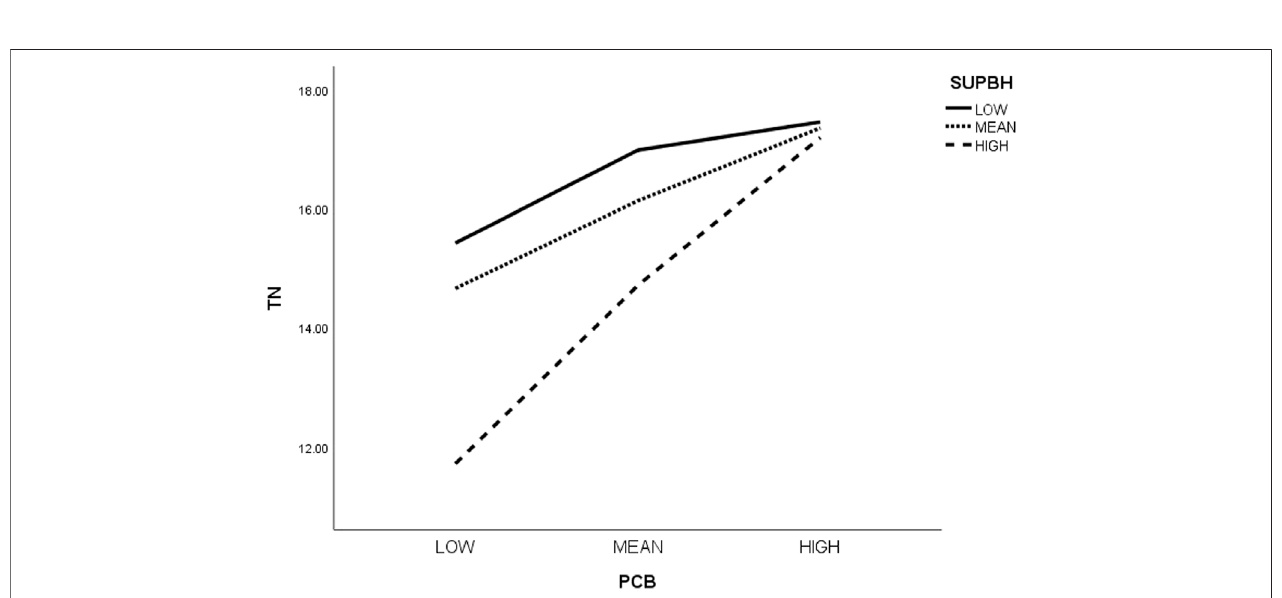
FIGURE 3 | Moderating role of organizational climate (supportive behavior) in the psychological contract breach and turnover intentions